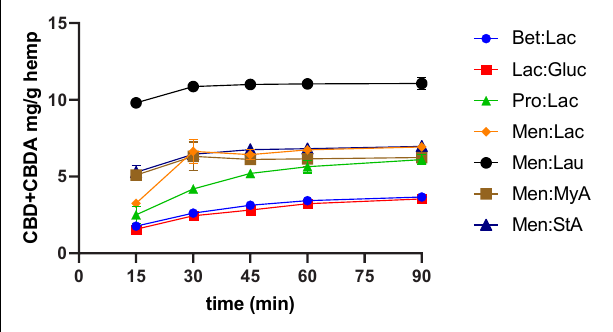
FIGURE 2 | Effect of time in CBD + CBDA extraction. Extraction conditions were 60 ◦ C, a 1:10 solid-liquid ratio.